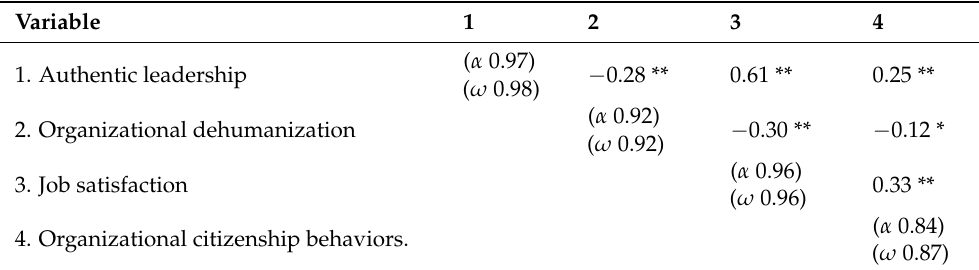
Table 5. Matrix of correlations between the study variables and reliability indexes.